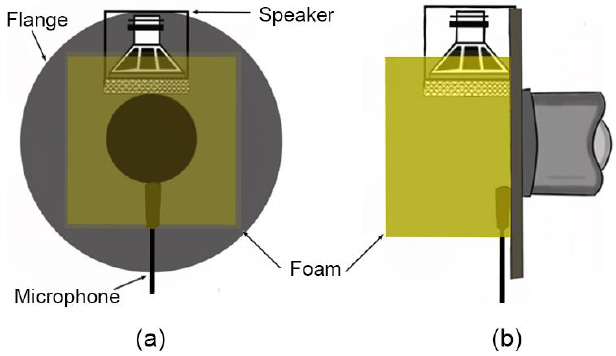
Figure 10. Schematic of configuration 9: ( a ) plane view; ( b ) side view.